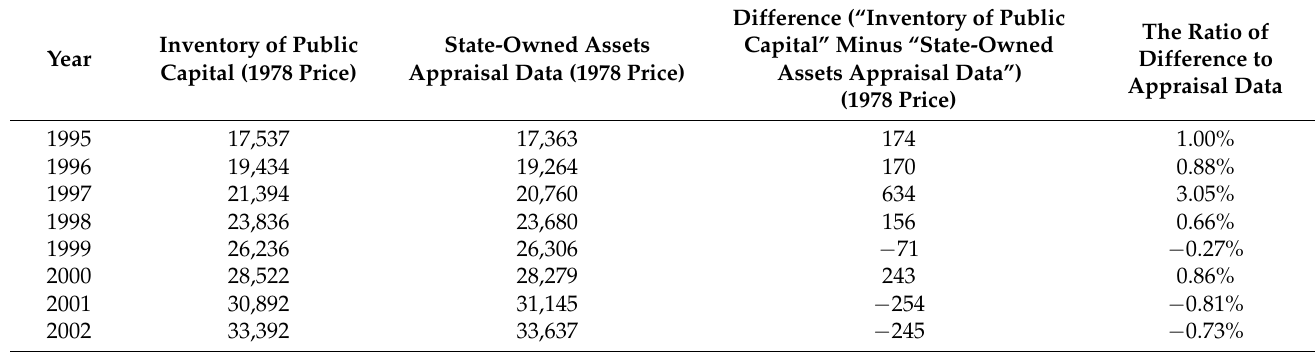
Table 1. Inventory of public capital versus liquidation of state capital over